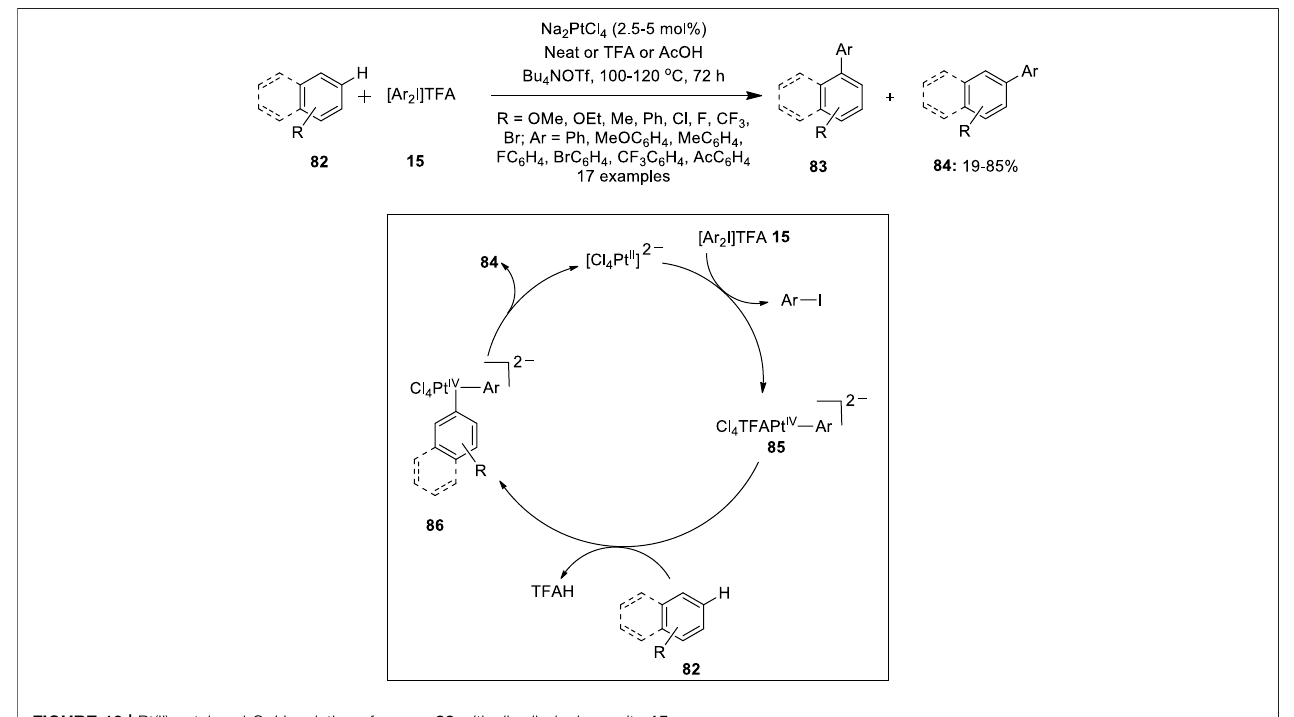
FIGURE 16 | Pt(II)-catalyzed C − H arylation of arenes 82 with diaryliodonium salts 15 .